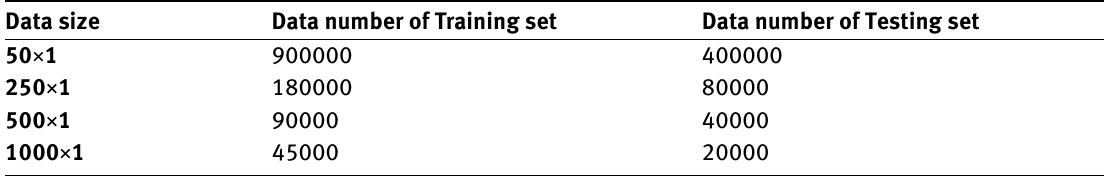
Table 2: Total amount of data of different size data. Data size Data number of Training set Data number of Testing set